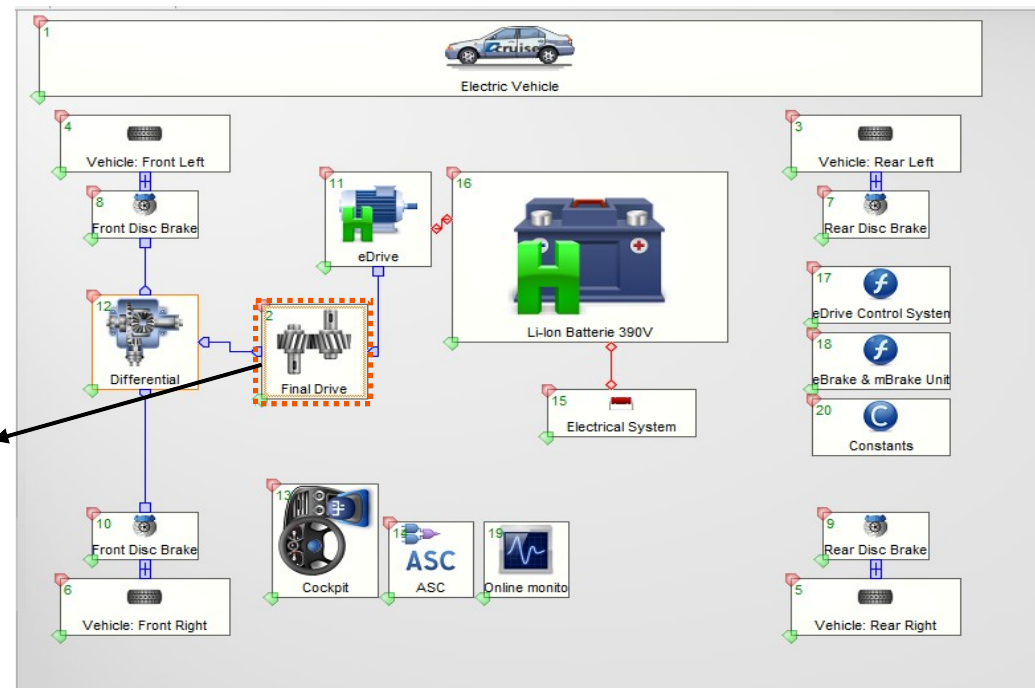
Table 1. Specifications of EV used in this study.